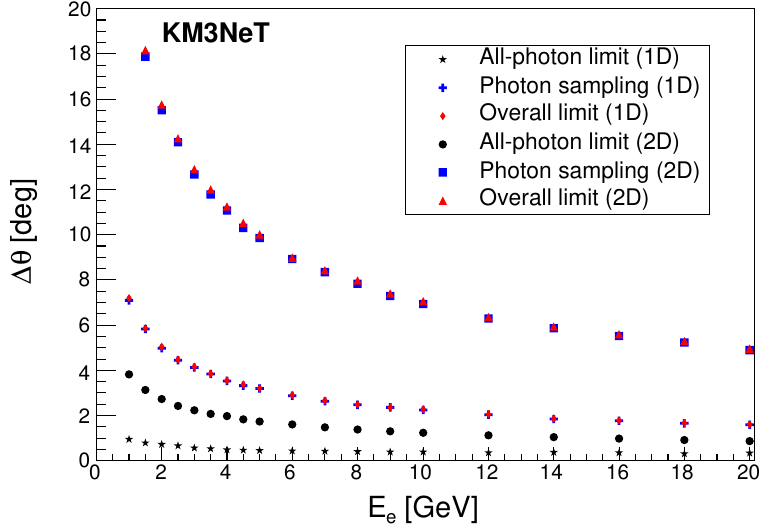
Figure 28 . Limiting resolutions on electron direction reconstruction (68% quantiles), using both the 1D method described in appendix C.2, and the 2D method described in section 3.2, in the case of the all-photon (black) and overall (red) limits. The e(cid:11)ect of photon sampling only is shown in blue (overplotted by red).